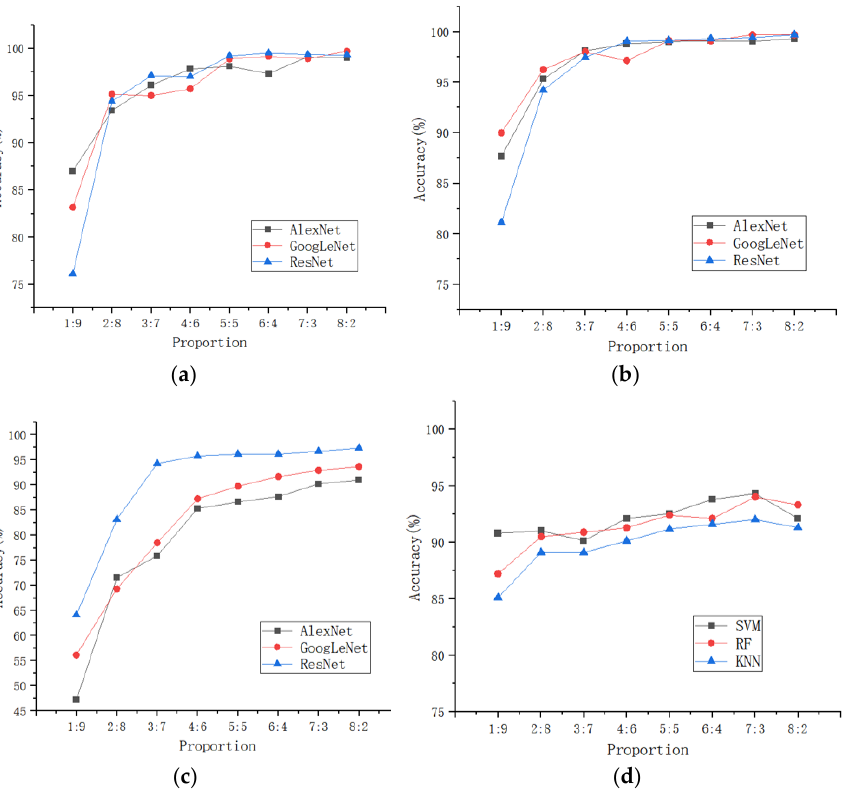
Figure 16. Correctness rates for different division ratios from 1:9 to 8:2: ( a ) Method 1, ( b ) Method 2, ( c ) Method 3, ( d ) Machine learning.